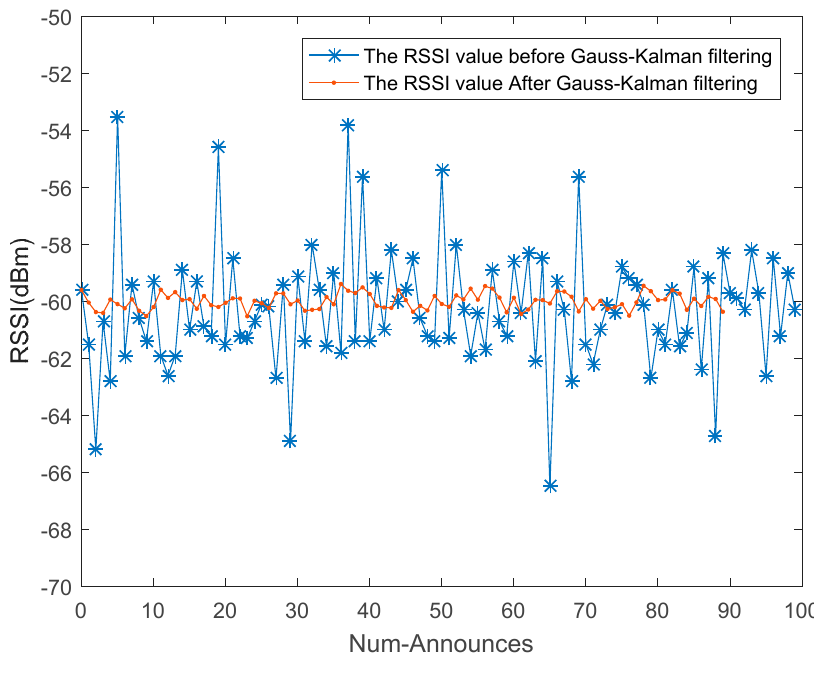
Figure 6. The RSSI value processed by the Gaussian-Kalman filter.